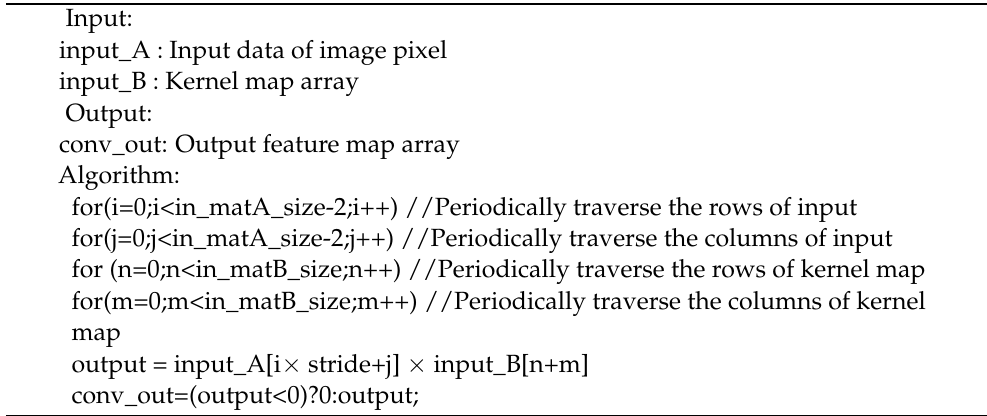
Algorithm 1: Convolution layer computation